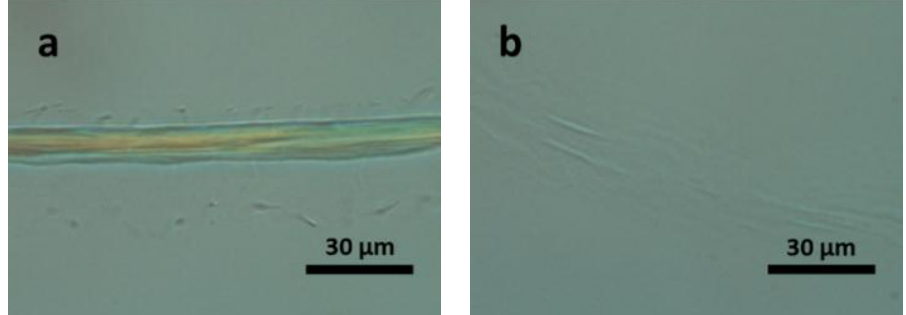
Figure 5. POM images of hydrogen peroxide (H [Bmim]OAc at 120 °C for: ( a ) 5 s; and ( b ) 180 s.